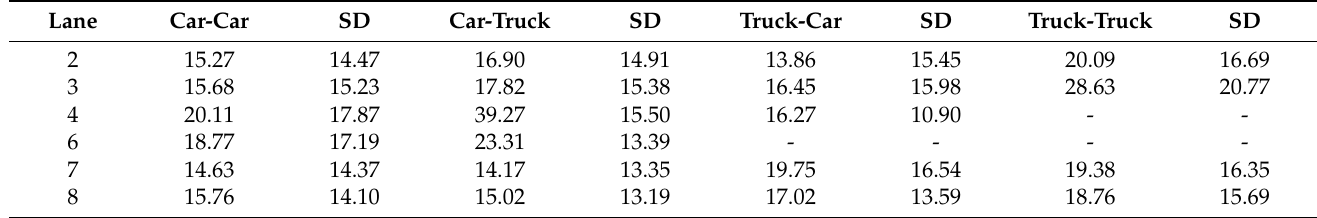
Table A5. The mean and standard deviation of TTCmin when lane changing.